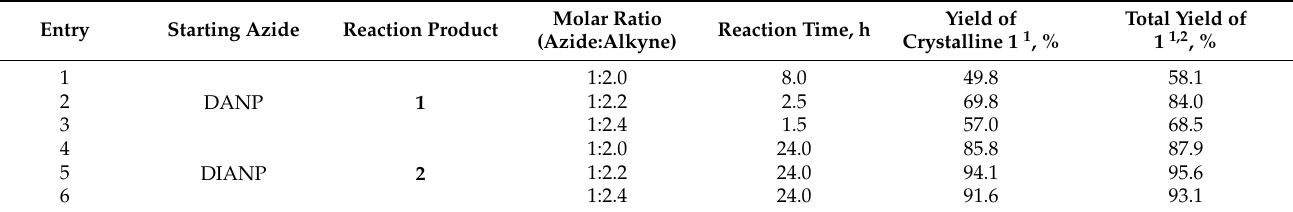
Table 4. Yields of 1 and 2 subject to the azide:alkyne molar ratio.